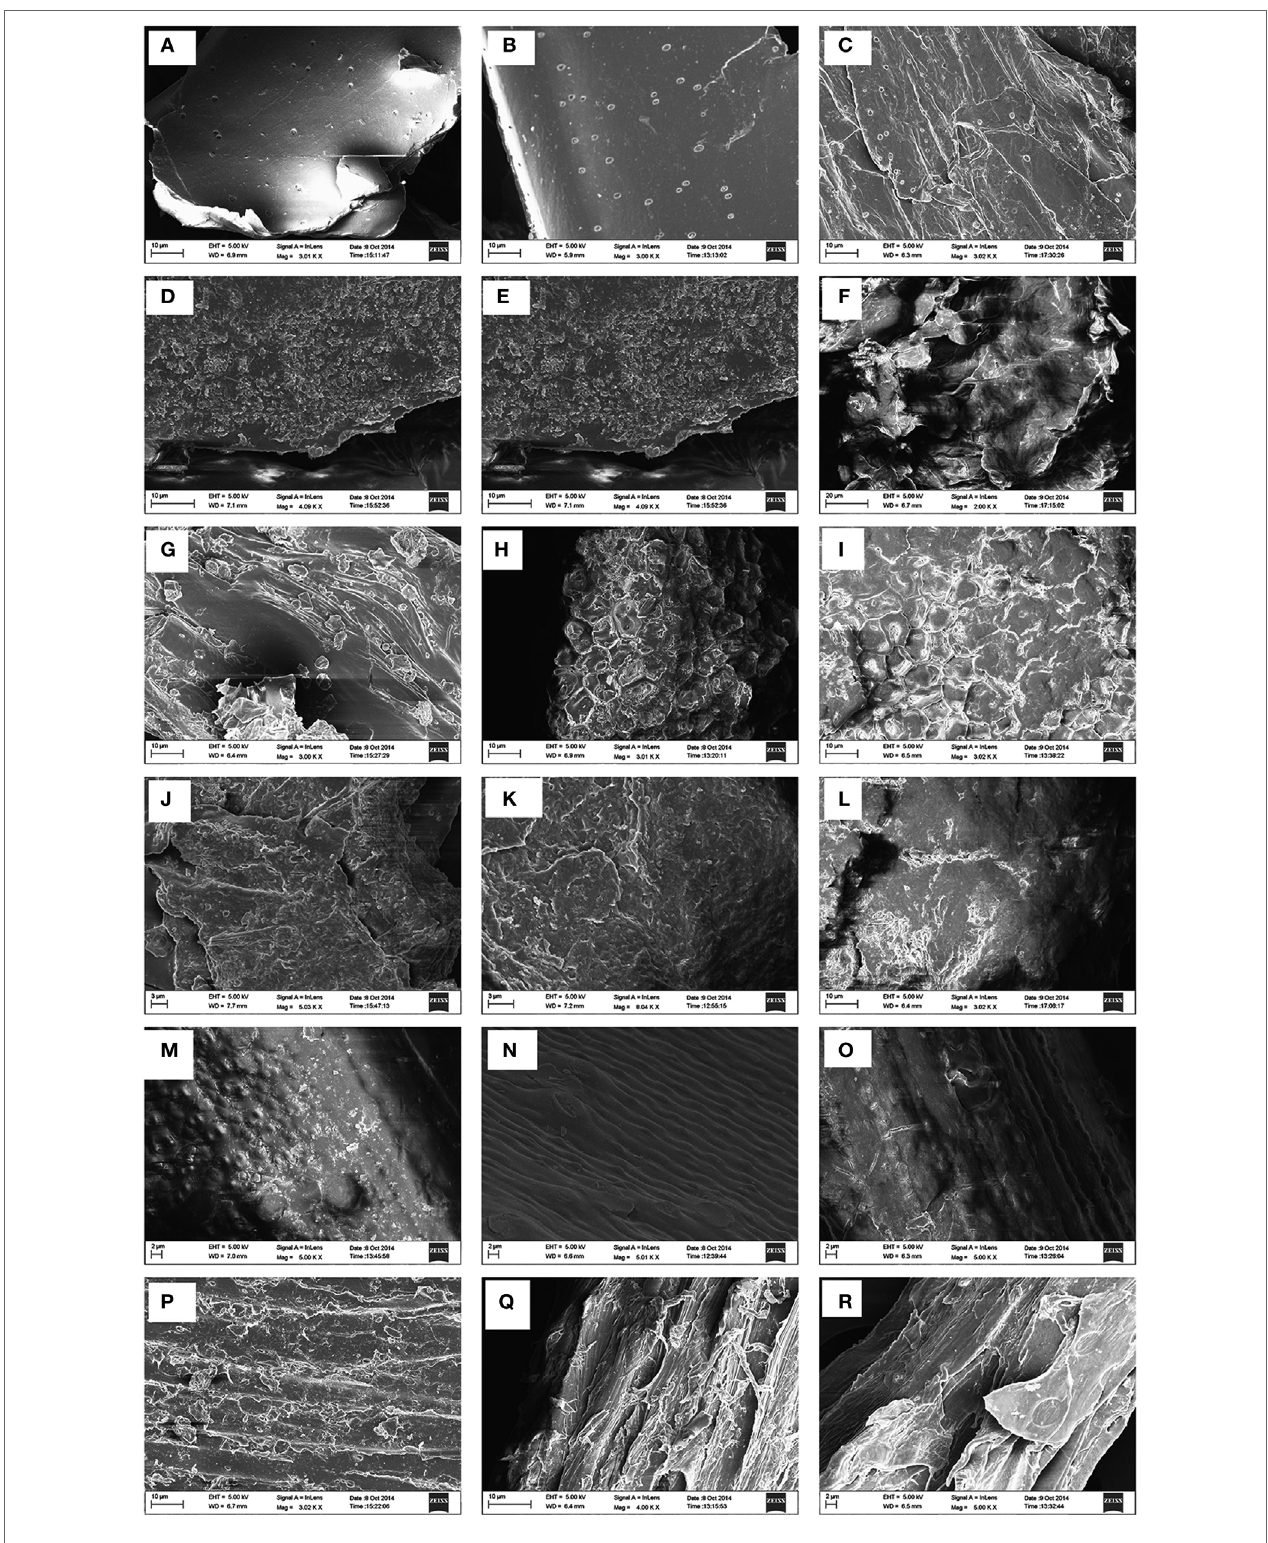
FigUre 1 | Scanning electron microscopy images of six types of lignocellulosic biomass. First row: sugarcane bagasse; second row: cassava aerial parts; third row: ficus fruits; fourth row: Loktak phumdi ; fifth row: rice straw; and sixth row: sawdust. Untreated: (a,D,g,J,M,P) ; hydrothermally pretreated: (B,F,h,K,n,Q) ; sodium hydroxide pretreated: (c,e,i,l,O,r)